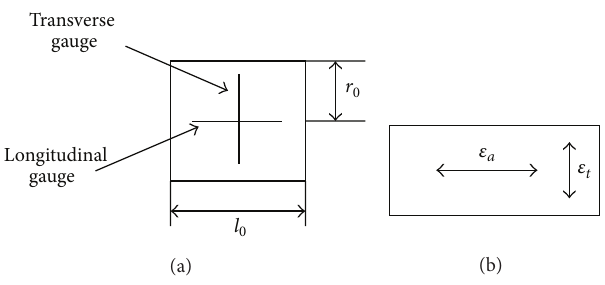
Figure 5: Elementary cylindrical volume: initial configuration (a) and deformed configuration